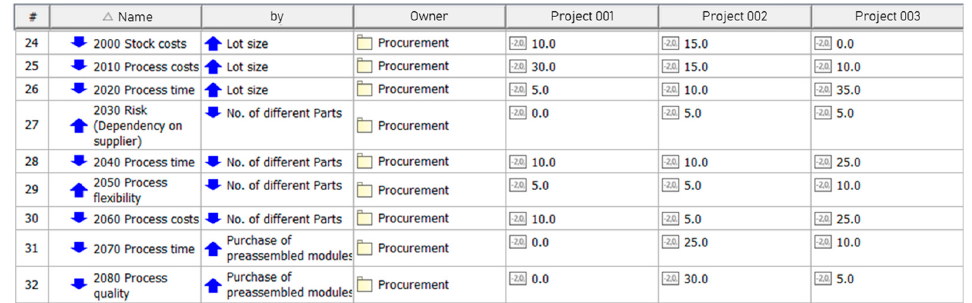
Figure 8. Data flow between Sys-IMF, Excel-IMF and maintenance tables for continuous and dynamic data management.